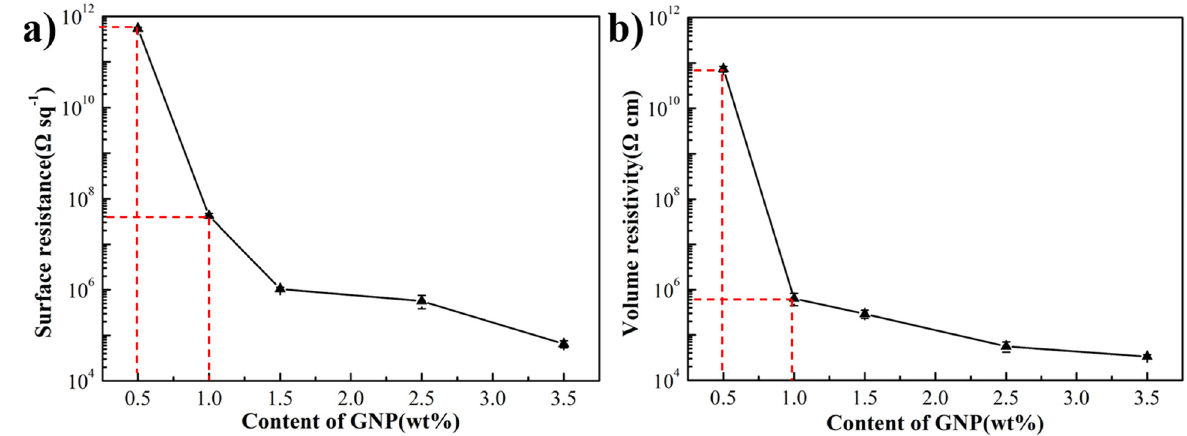
Figure 4: Surface resistivity ( a ) and volume resistivity ( b ) of PP/GNP